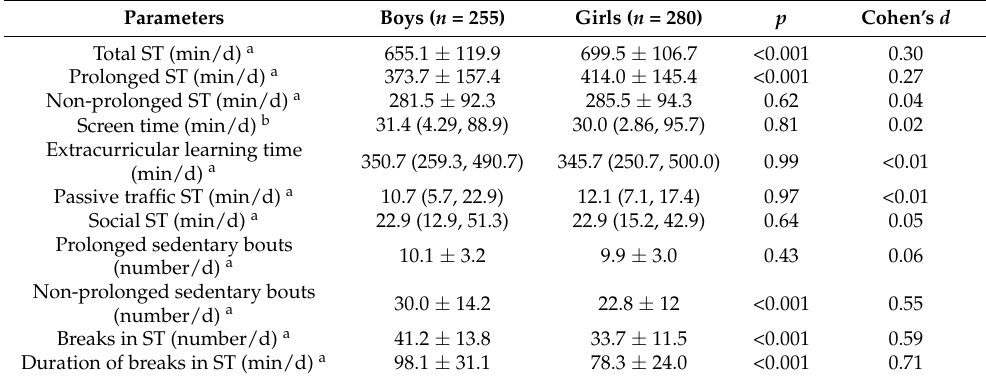
Table 2. Descriptive characteristics of ST and SP.